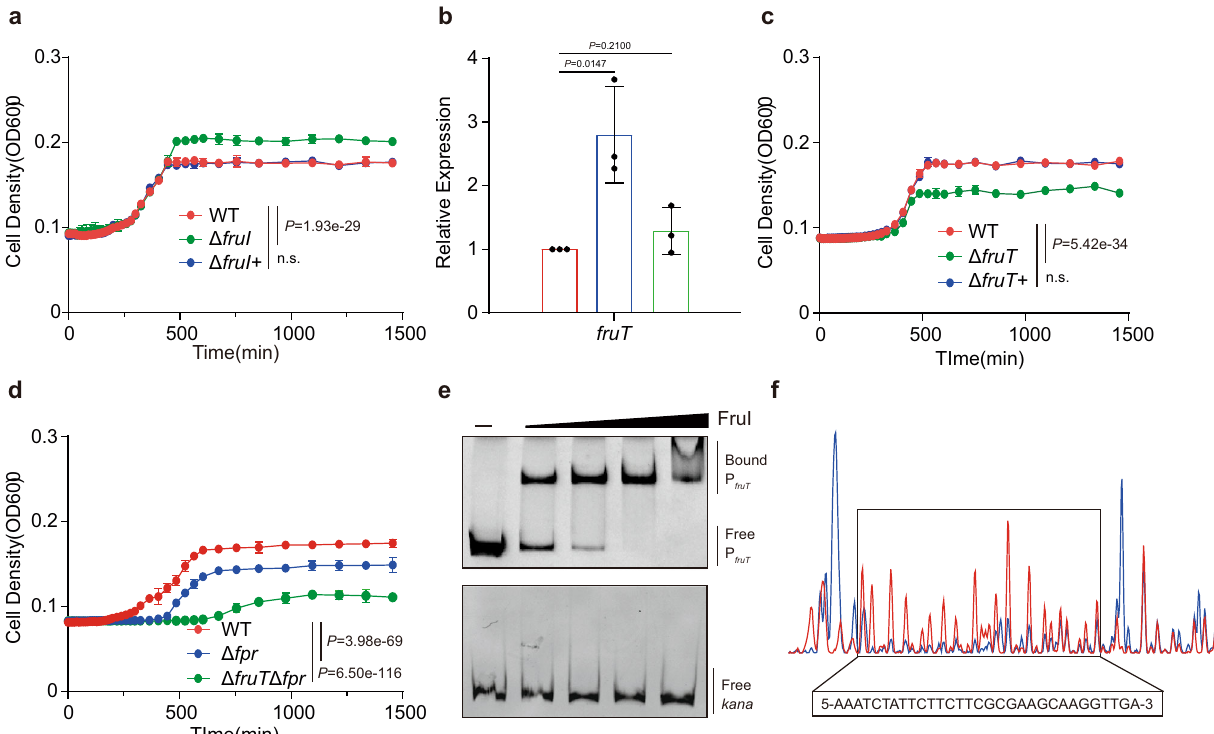
Fig. 1 FruI represses the expression of the putative fructose transporter FruT. a Growth curves of WT, Δ fruI , and Δ fruI + in M9 medium containing 30 mM fructose as the only carbon source. Data represent the mean ± SD ( n = 3). b qRT-PCR expression level of fruT in WT, Δ fruI , and Δ fruI + in M9 medium containing 30 mM fructose as the only carbon source. Data represent the mean ± SD ( n = 3). c Growth curves of WT, Δ fruT , and Δ fruT + in M9 medium containing 30 mM fructose as the only carbon source. Data represent the mean ± SD ( n = 3). d Growth curves of WT, Δ fpr , and Δ fruT Δ fpr in M9 medium containing 30 mM fructose as the only carbon source. Data represent the mean ± SD ( n = 3). e EMSA of the speci fi c binding of puri fi ed FruI protein to the promoter region of fruT and kana (negative control). f FruI binds to a motif in the fruT promoter region. The protected region shows a signi fi cantly reduced peak intensities (blue) pattern than seen in compared with those of the control (red). The identi fi ed FruI-binding motif is shown in a box at the bottom of the fi gure. Images are representative of three independent experiments ( e ). Signi fi cance is determined by two-tailed unpaired Student ’ s t test ( b ) or two- way ANOVA ( a , c , d ) and indicated as the P value; n.s. means no signi fi cant difference. Source data are included in Source Data fi